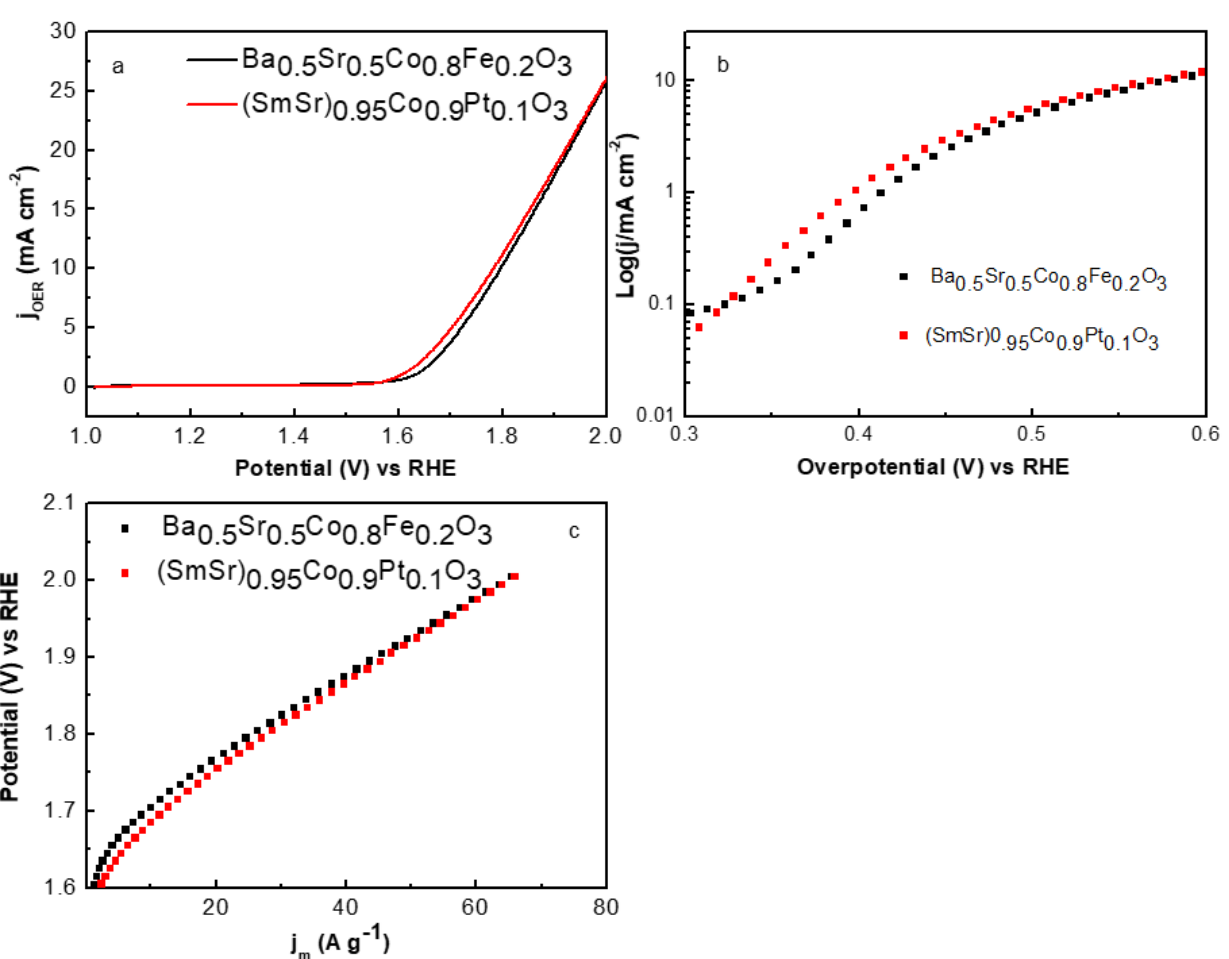
Table 1. Physical and electrocatalytic properties of the perovskite-based catalyst materials studied